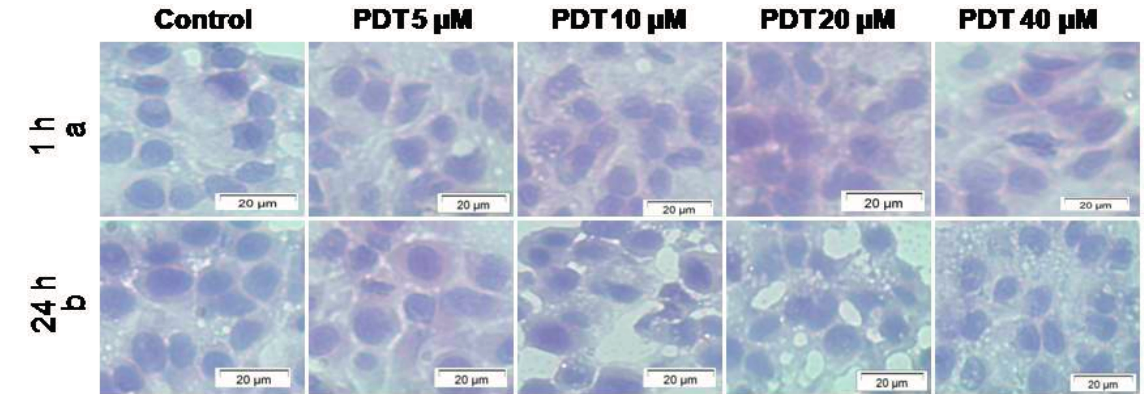
Figure 2. Cryosections of A549 multicellular tumour spheroids (MCTSs) with a size of 500 µm stained with haematoxylin and eosin (H&E) stain, 1 h ( a ) and 24 h ( b ) post irradiation. Control MCTSs were exposed to neither light nor PS while other groups were treated with increasing concentrations of ZnPcS mix (5, 10, 20 and 40 µM) and 5 J/cm 2 . Untreated MCTSs appeared as large cells with prominent cytoplasm and well